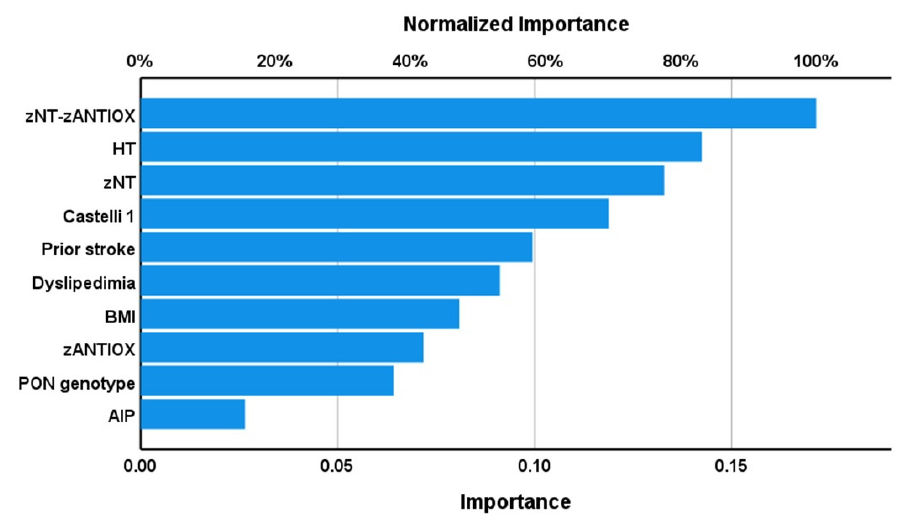
Figure 2. Importance chart of a neural network analysis with acute ischemic stroke (AIS) versus controls as input variables and composite scores of the predictors as input variables. zNT—z composite score of the neurotoxic analytes assayed in our study; HT—hypertension; zANTIOX—z composite score of the antioxidants assayed in our study; Castelli 1—an index of the Castelli risk